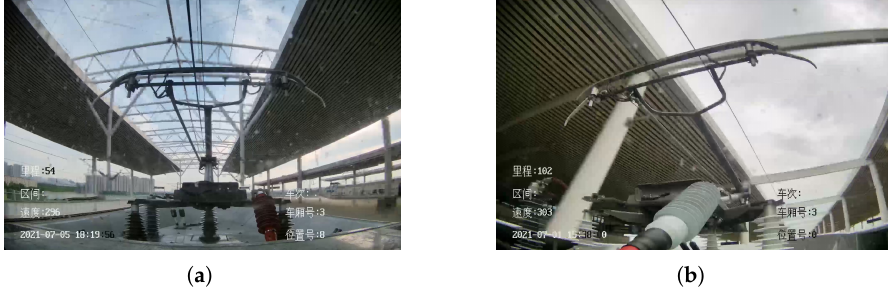
Figure 14. Platform affects pantograph detection. ( a ) HSR-A. ( b )